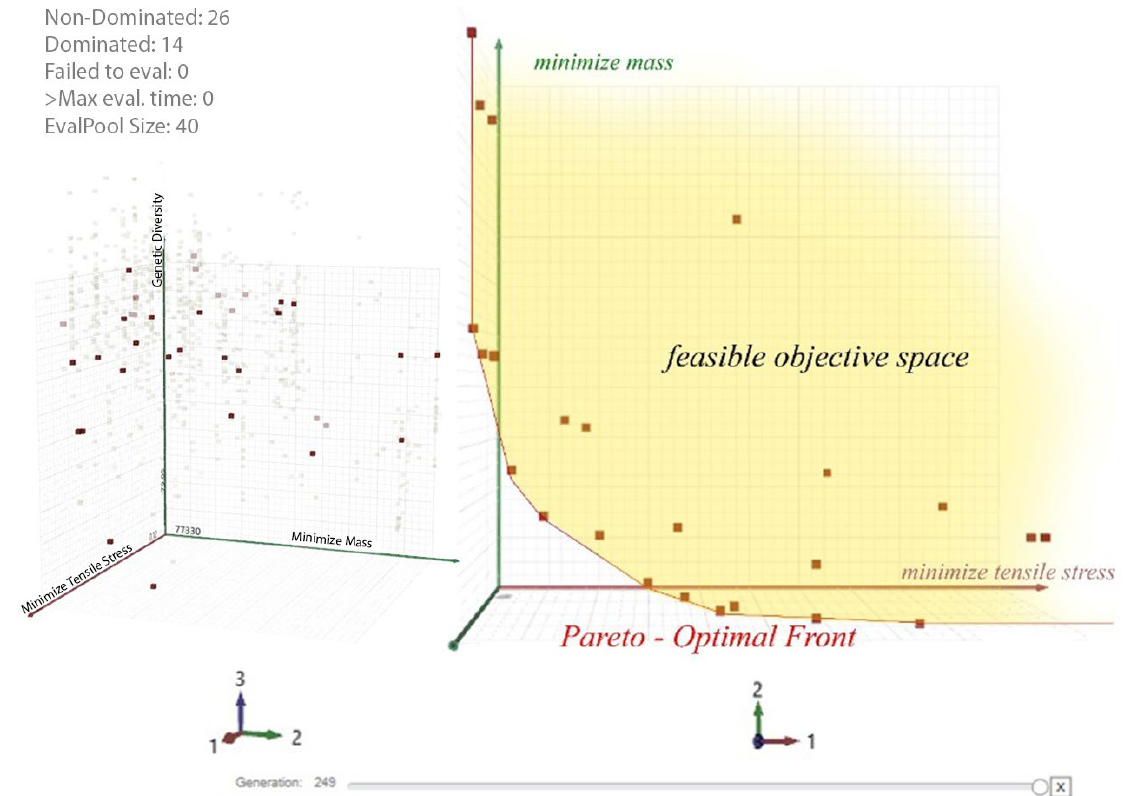
Figure 18. Pareto optimal front; in red, all feasible solutions.